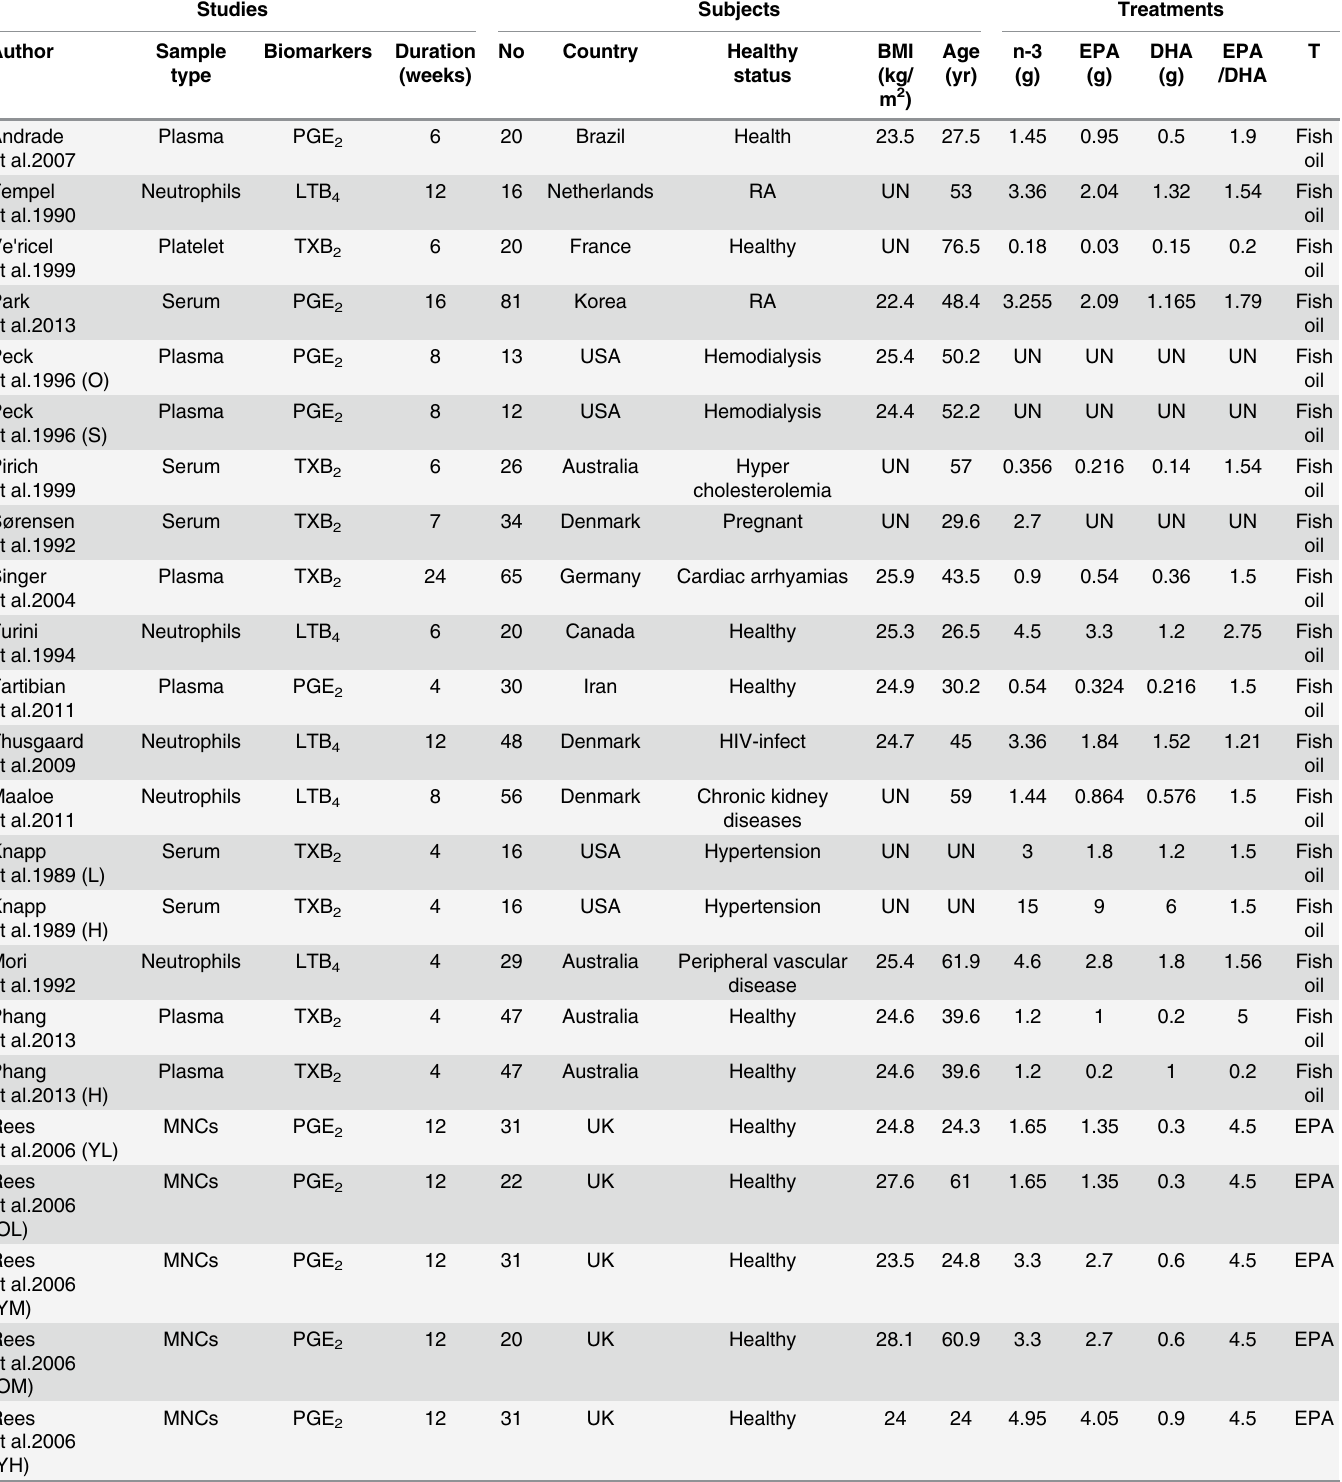
Table 1. Characteristics of included studies for systematic review and